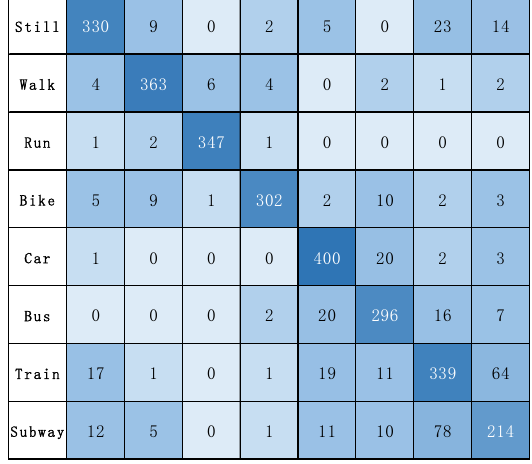
Figure 8. The confusion matrix of T2Trans on the SHL dataset.